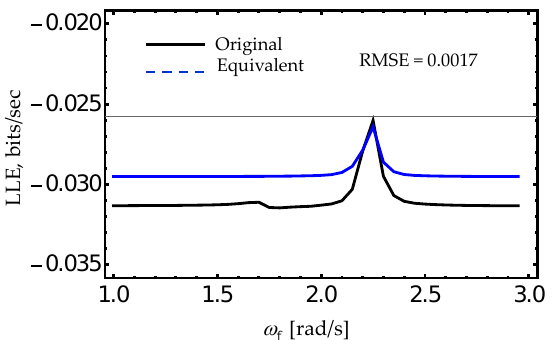
Figure 9. LLE curves computed from the numerical integration solutions of Equations (29) and (43). The parameter values used to obtain these plots were 𝑚 1 = 10 kg, 𝑚 2 = 0.6 kg, 𝑐 1 = 0.1 Ns/m, 𝑐 2 = 0.08 Ns/m, 𝑘 1 = 44 N/m, 𝑘 2 = 8 N/m 3 , 𝑘 3 = 2 N/m, 𝑘 4 = −0.15 N/m 3 , 𝑓 0 = 0.37 N. Here, the black line represents the LLE computed from the numerical integration solutions of Equation (43), while the blue line describes the LLE obtained from Equation (29).